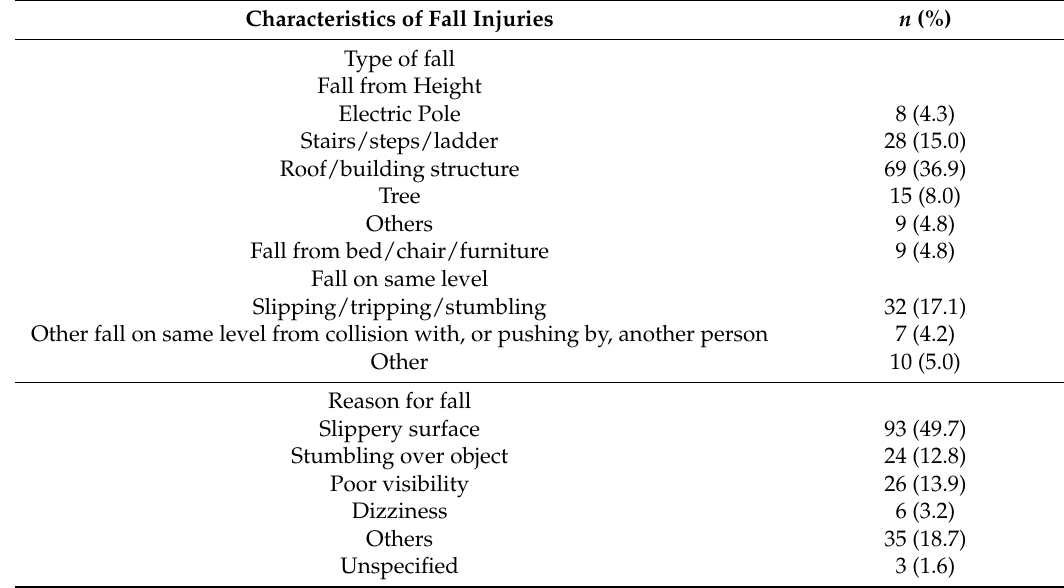
Table 3. Characteristics of fall injuries ( n = 187).